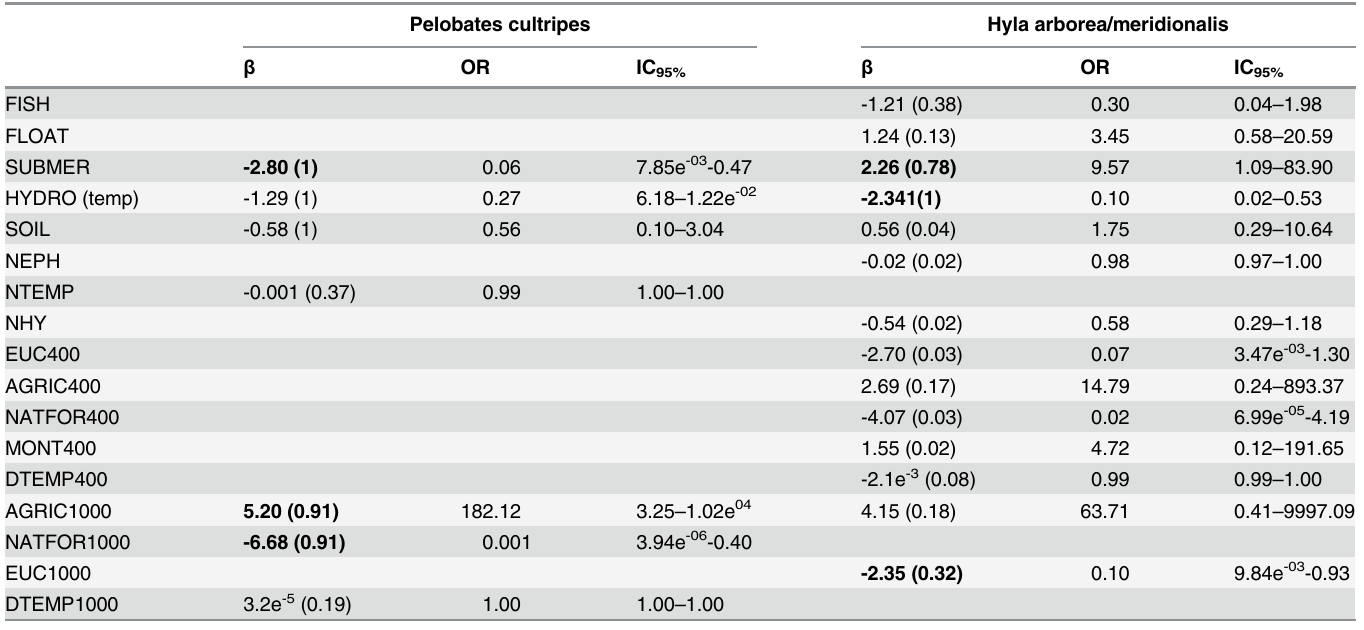
Table 3. Model averaged parameter estimates ( β )(top-ranked models) for each of the anurans, odds ratio (OR) and respective 95% confidence in- tervals (IC 95%